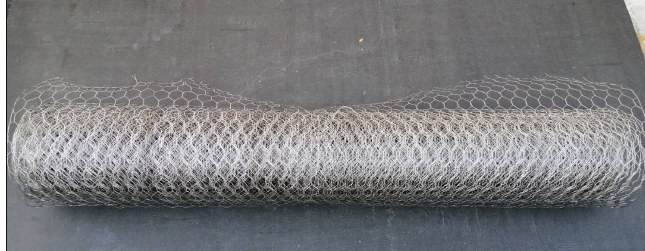
Figure 8. Typical view of wire mesh.